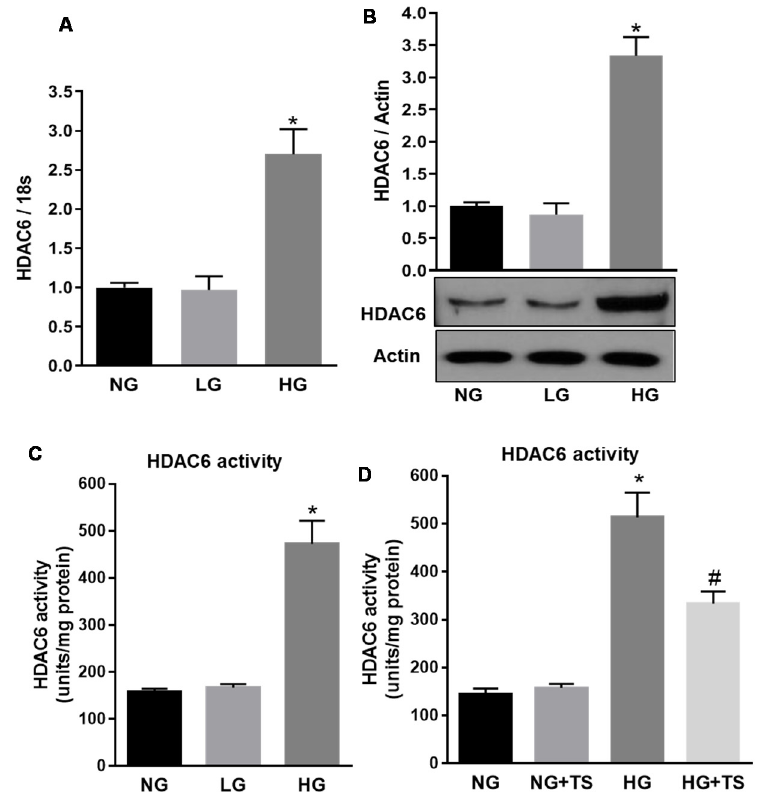
Figure 7. E ff ects of high glucose and Tubastatin A on HDAC6 expression and activity in HuREC. ( A ) HDAC6 mRNA expression, measured by qPCR, in HuREC exposed to di ff erent glucose levels (NG = 5.5 mM d -glucose, HG = 25 mM d -glucose) and the osmotic control l -glucose (25 mM) for 48 and 72 h. ( B ) Immunoblotting showing HDAC6 protein levels measured 48 h after exposure of HuREC to HG or the controls NG or LG. ( C ) HDAC6 activity measured in HuREC by fluorimetric assay at 48 h exposure of the cells to HG, NG or LG. ( D ) HDAC6 activity measured in HuREC by fluorimetric assay after 48 h of exposure of the cells to HG or HG plus TS (5 µ M starting 6 h before HG treatment) and compared to the controls NG or LG. Values are mean ± SEM for n = 3. * p < 0.01 vs. NG and # p < 0.01 vs.